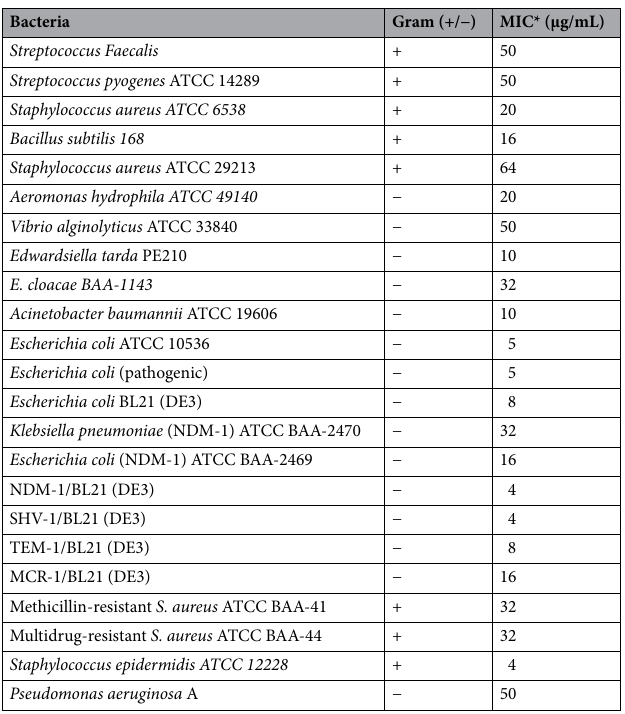
Table 1. Antibacterial activity of newly predicted peptide on normal (upper) or drug resistant bacteria (lower). *MIC: the lowest concentration of an antimicrobial agent that can inhibit the growth of bacteria after overnight